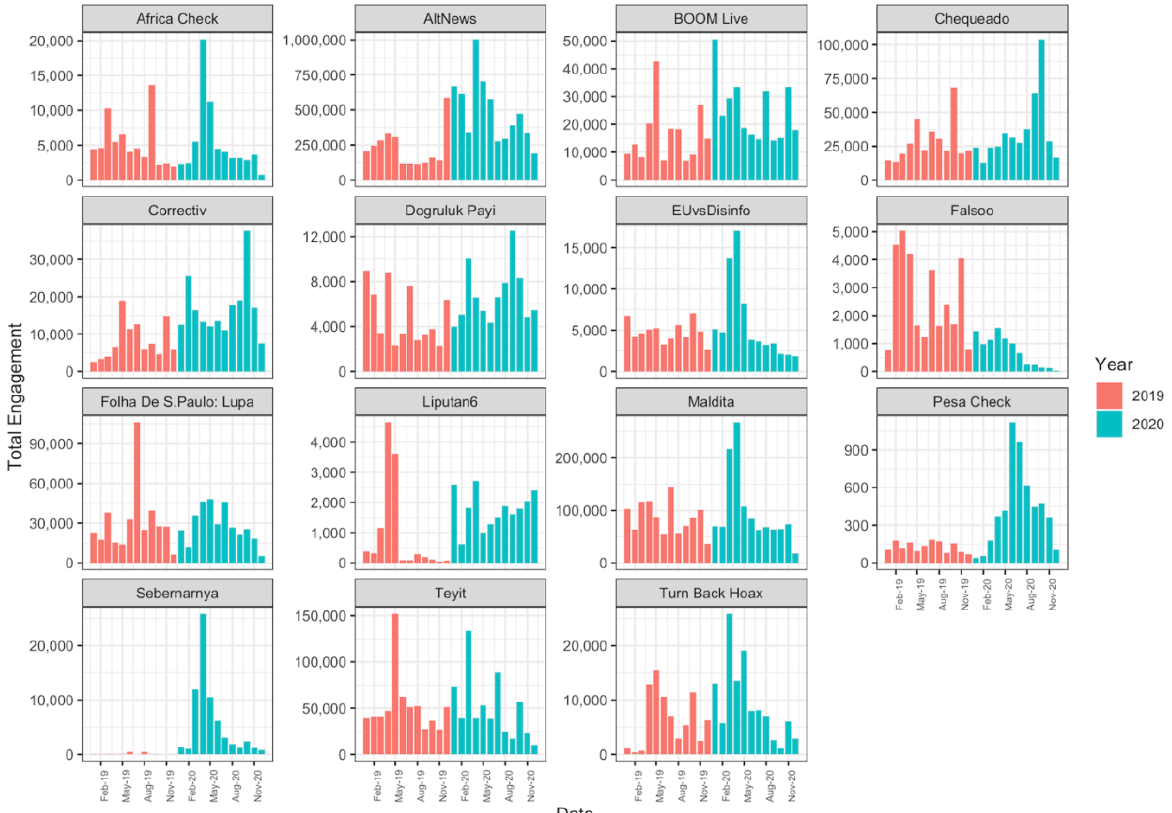
Figure 3. Total engagement by users per month in 2019 and 2020. We measure user engagement to fact-checking as the sum of likes, retweets, quote tweets, and replies to all fact-checking content as well as the number of posts by users that included a URL to a fact- checking organization’s website